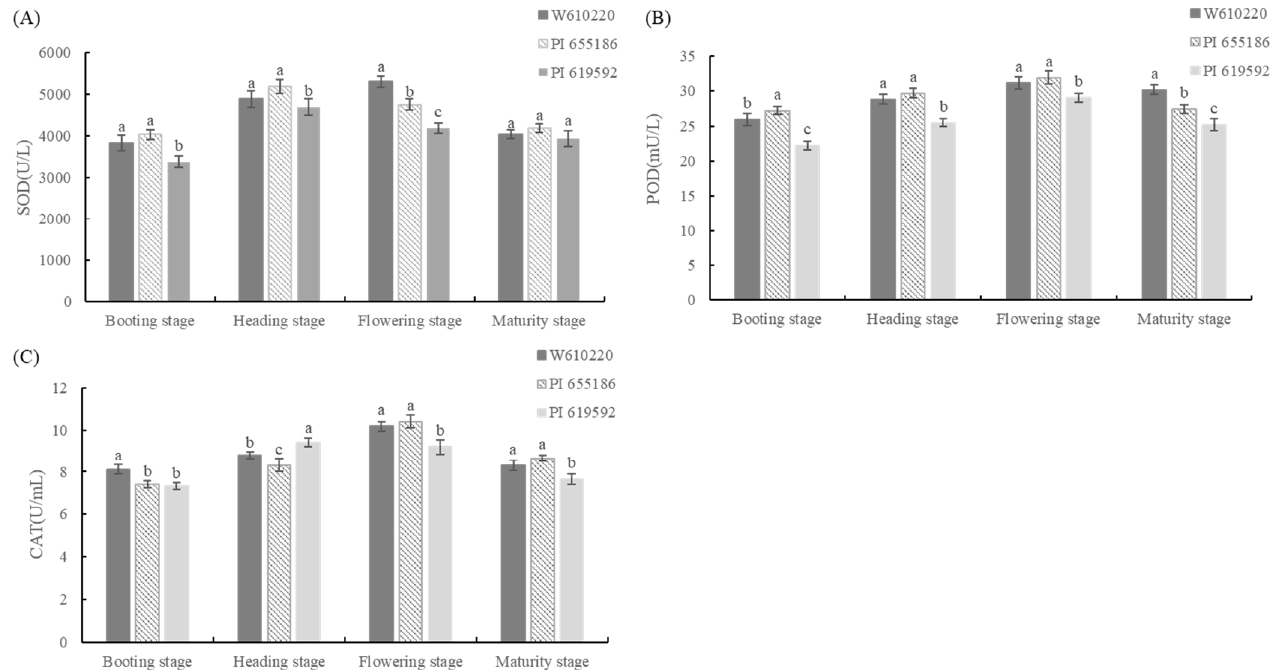
Figure 9. Changes of antioxidant enzyme content in awns of three accessions at four developmental stages: ( A ) Superoxide dismutase, ( B ) Catalase, ( C ) Peroxidase. Error bars represent mean ± standard deviation. Different normal letters mean significant differences among different treatments at 0.05 level.